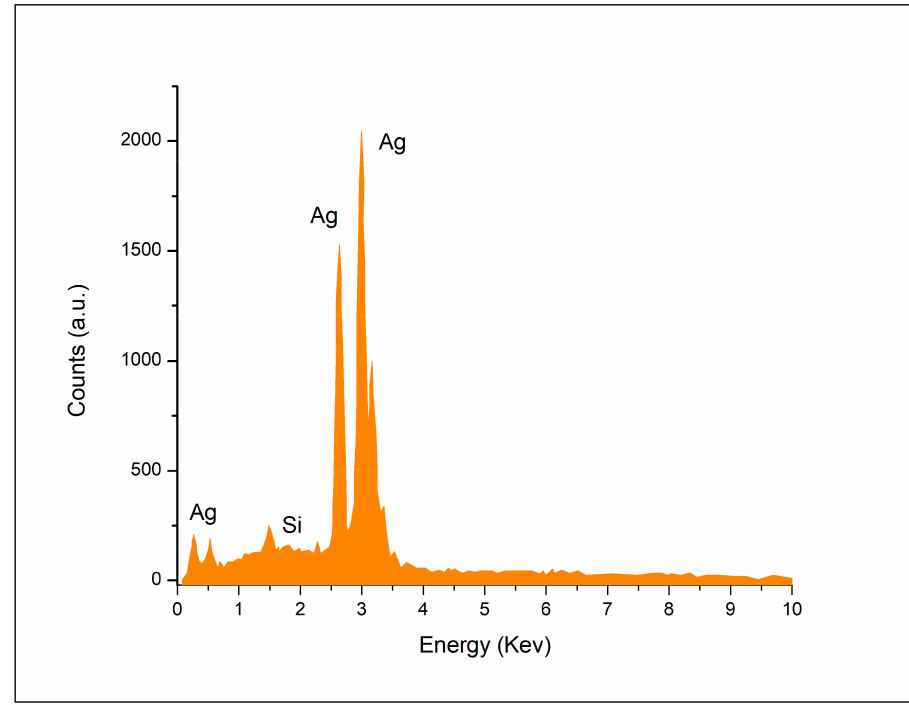
Figure 6. EDX spectrum of CB-AgNPs.